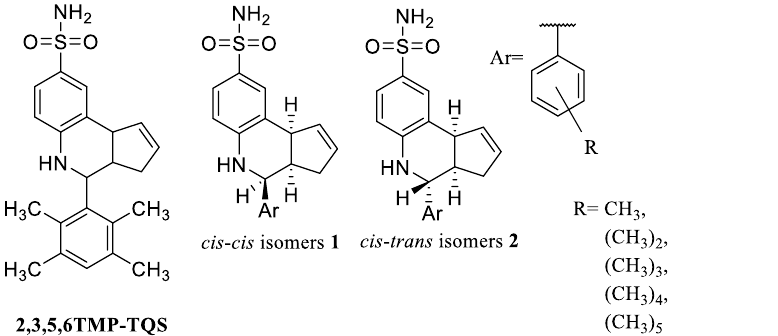
Figure 10. Allosteric modulators with different pharmacological profile based on stereochemistry.